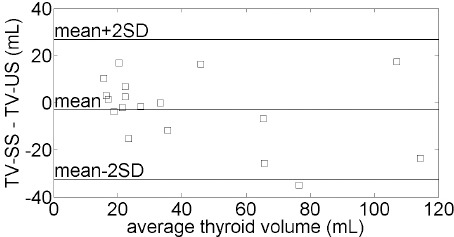
Bland-Altman plot of thyroid volume (TV) in 18 patients with Graves’ disease (GD), measured using SUV-shape (SS) scheme and ultrasonography (US). The standard deviation of the difference between the two measurements (TV-SS – TV-US) is 18.3 mL